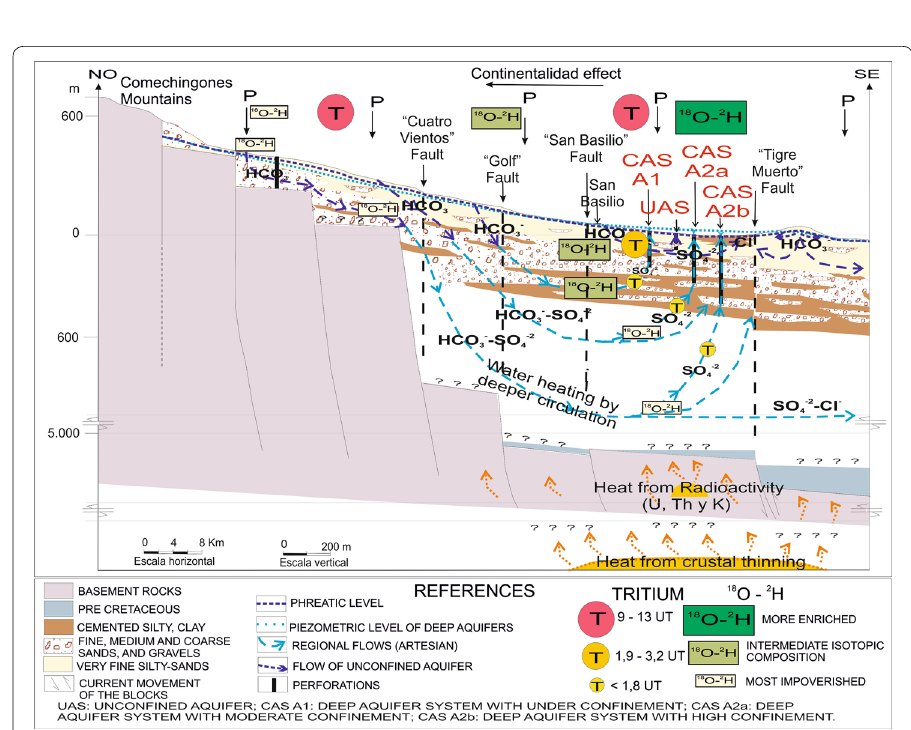
Fig. 7 Hydrogeological model San Basilio-La Brianza aquifer systems (Cabrera et al.